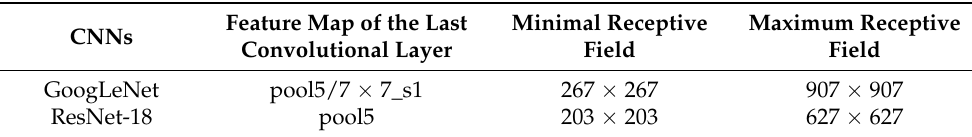
Table 2. The maximum and minimum values of the receptive field of the last convolution layer of feature maps of GoogLeNet and ResNet-18. Feature Map of the Last Minimal Receptive CNNs Convolutional Layer